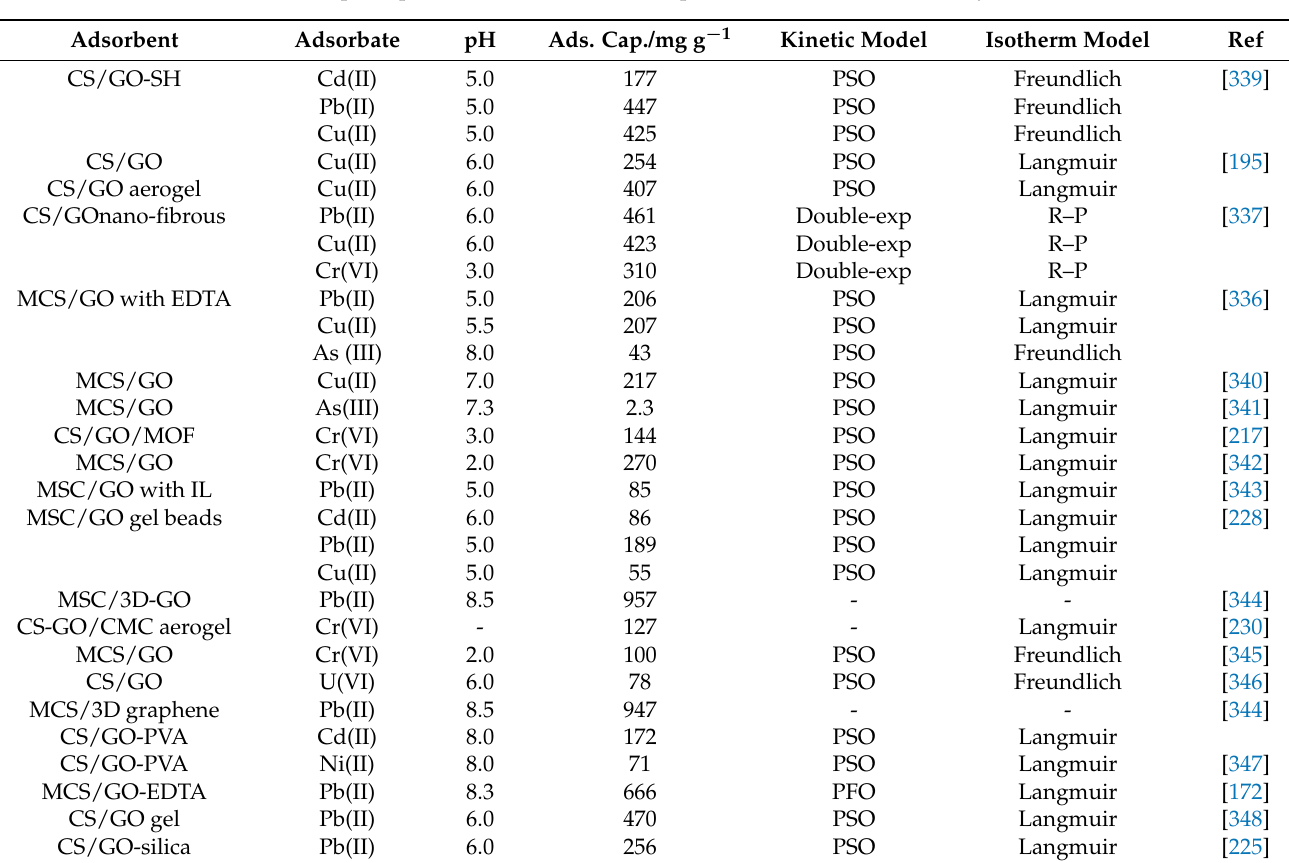
Table 5. Adsorption performance of CS/GO composites in the removal of heavy metal